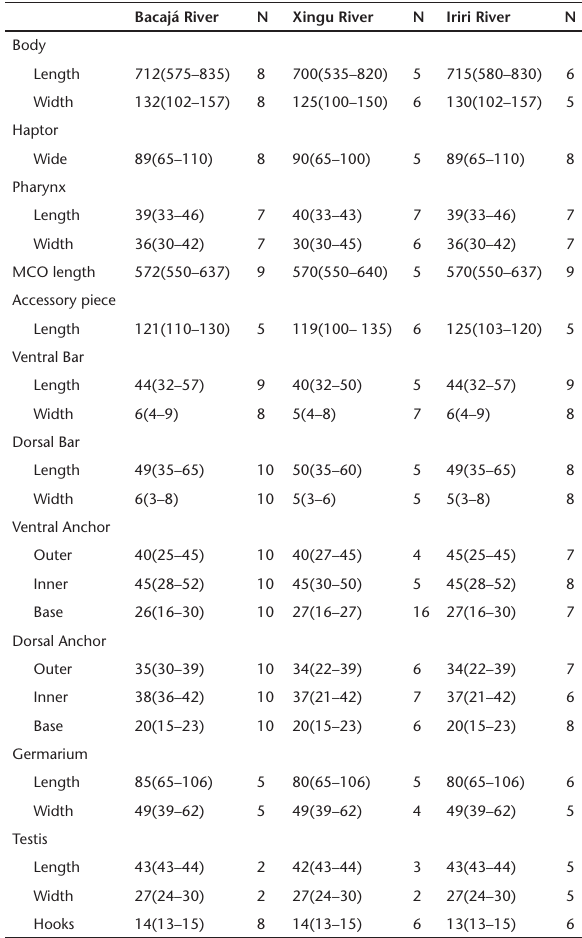
Table 4. Comparative measurements (μm) of specimens of Cos- metocleithrum leandroi sp. nov. from the gills of Hassar gabiru from three locations.